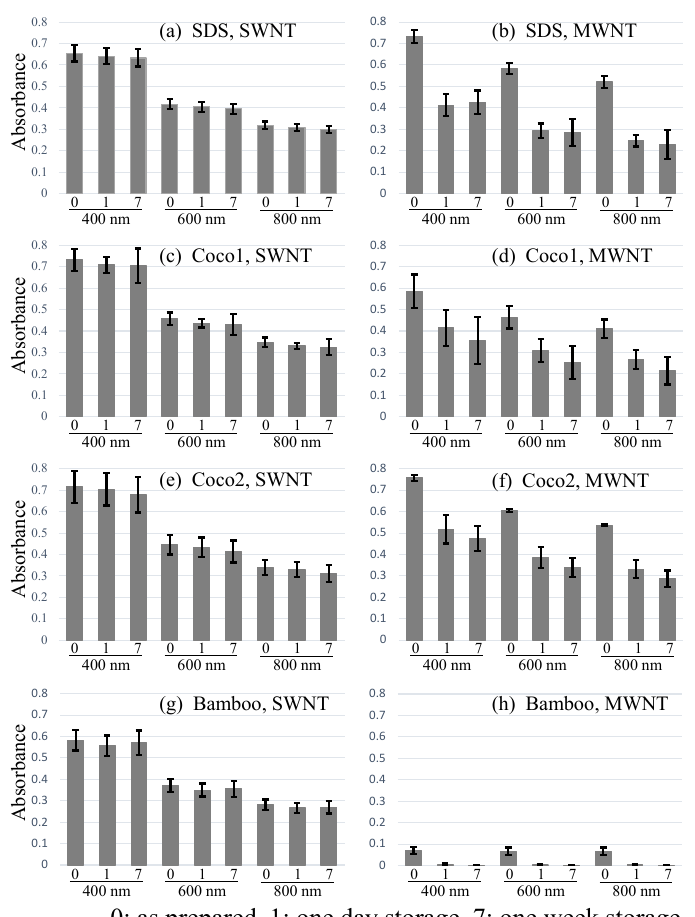
Figure 2. Histograms of absorbance of CNT suspensions at 400, 600, and 800 nm. ( a ) SWNTs with SDS, ( b ) MWNTs with SDS, ( c ) SWNTs with Coco1, ( d ) MWNTs with Coco1, ( e ) SWNTs Coco2, ( f ) MWNTs with Coco2, ( g ) SWNTs with Bamboo, ( h ) MWNTs with Bamboo. 0: As prepared, 1: 1-day storage, 7: 7-days storage.